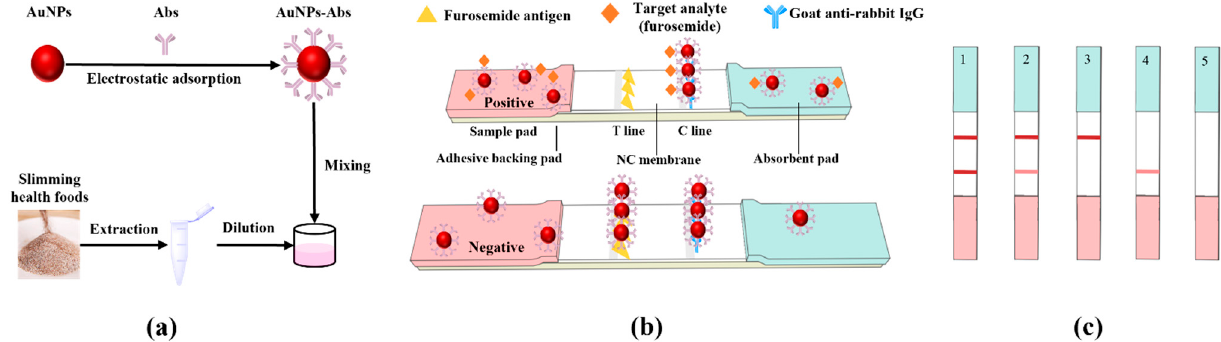
Figure 1. Schematic of the Au nanoparticles lateral flow immunochromatography (AuNPs-LFIA) for detecting furosemide in slimming coffee. ( a ) Preparation of the signal probe AuNPs–Abs and the sample treatment solution. ( b ) The structure and test procedure of the AuNPs-LFIA test strip. C line: control line (goat anti-rabbit immunoglobulin G, IgG) and T line: test line (furosemide coating antigen). ( c ) Schematic diagram of AuNPs-LFIA strip test results: 1, negative result; 2, weak positive result; 3, positive result; 4–5, invalid result.